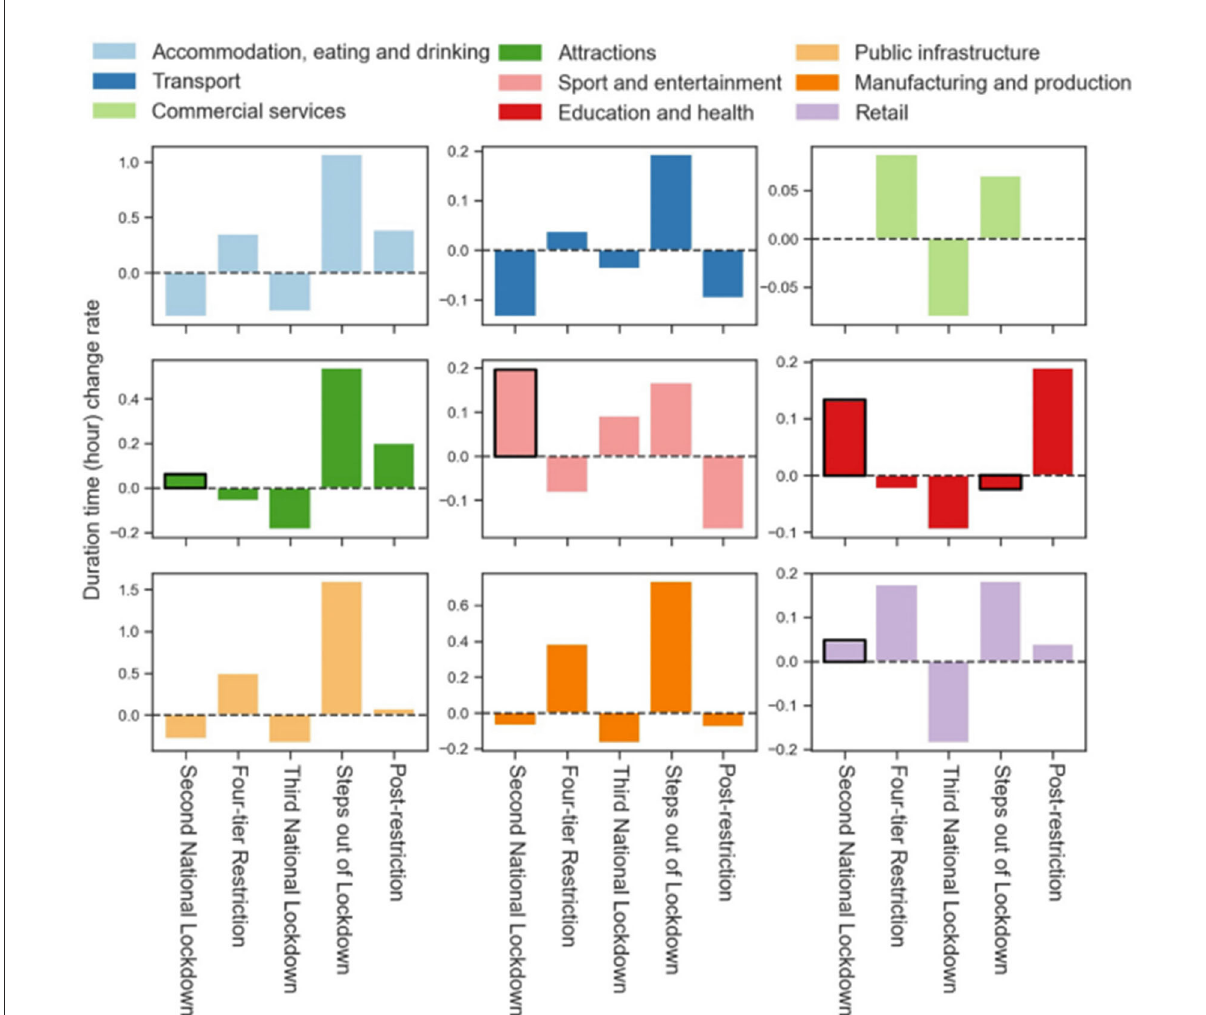
FIGURE4 The change rates of place visit indicators in the six restriction periods. The bars with black boxes denote: (1) The increased change rates in “Second National Lockdown” (compared to “Three-tier Restriction”), and the declined change rate in “Step out of Lockdown” (compared to “Third National Lockdown”); (2) The KWH results show visit indicators are significantly different between the two consecutive periods.